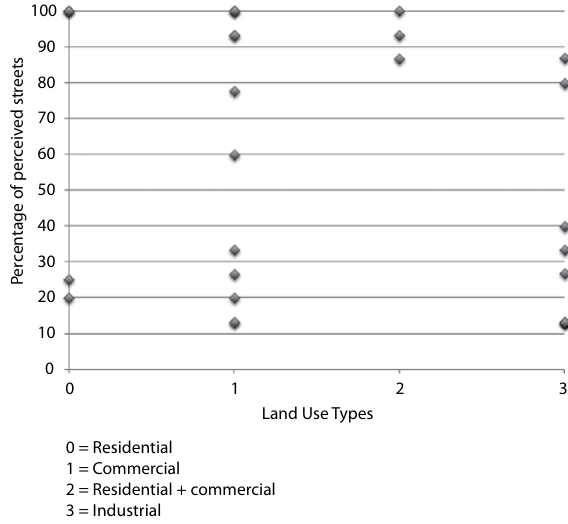
11. Comparison chart between street land use services and percentage of perceived streets in Kenmore and Kendall